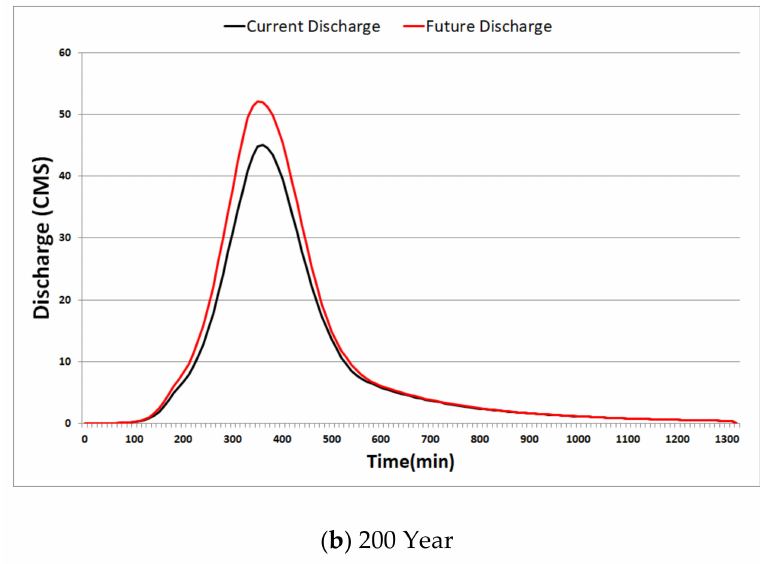
Figure 12. Calculation of Discharge by